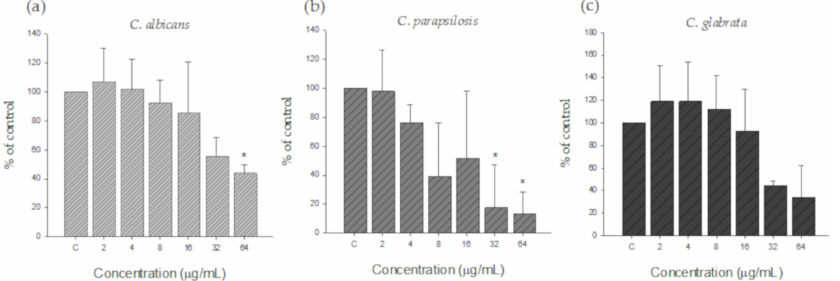
Figure 6. Activity of AgNPs against pre-formed biofilm of ( a ) C. albicans , ( b ) C. parapsilosis , and ( c ) C. glabrata . All species formed biofilm prior to treatment with AgNPs. The silver nanoparticles were prepared at final concentrations ranging from 2 to 64 µ g /